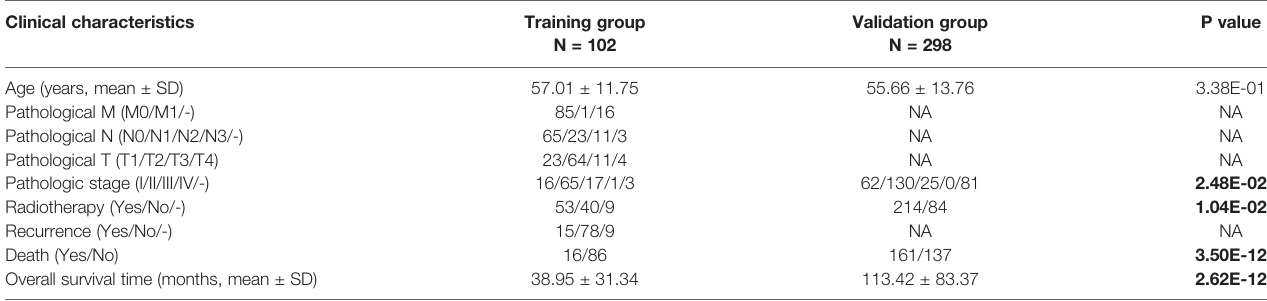
TABLE 1 | Clinical characteristics of TNBC patients in the training and validation